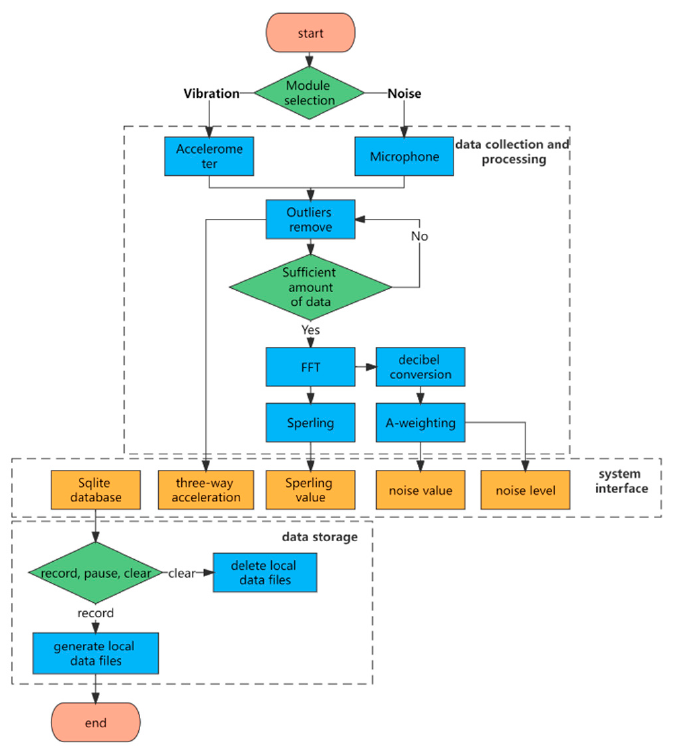
Figure 2. The overall flow of the system.